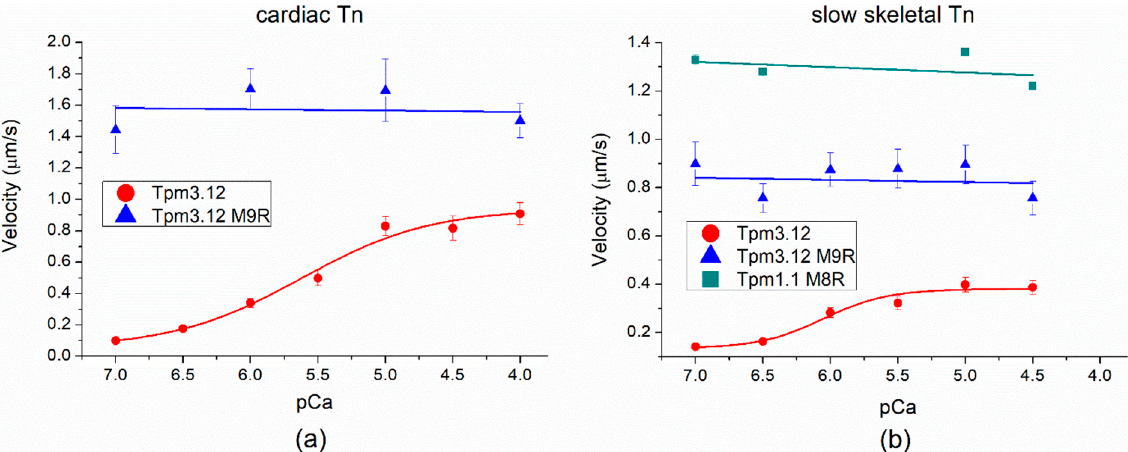
Figure 8. The Ca 2+ -dependent sliding velocity of regulated thin filaments in the presence of cardiomyopathy-causing mutant M8R of Tpm1.1 or myopathy-causing mutant M9R of Tpm 3.12. ( a ) The system contains cardiac Tn complex and cardiac myosin; ( b ) the system contains slow skeletal Tn complex and cardiac myosin. The pCa 50 values at which the sliding velocity was half-maximal are shown in Table 4. Table 4. Effects of Tpm mutations on the characteristics of the pCa-velocity dependence in the pres- ence of cardiac or slow skeletal Tn complex.